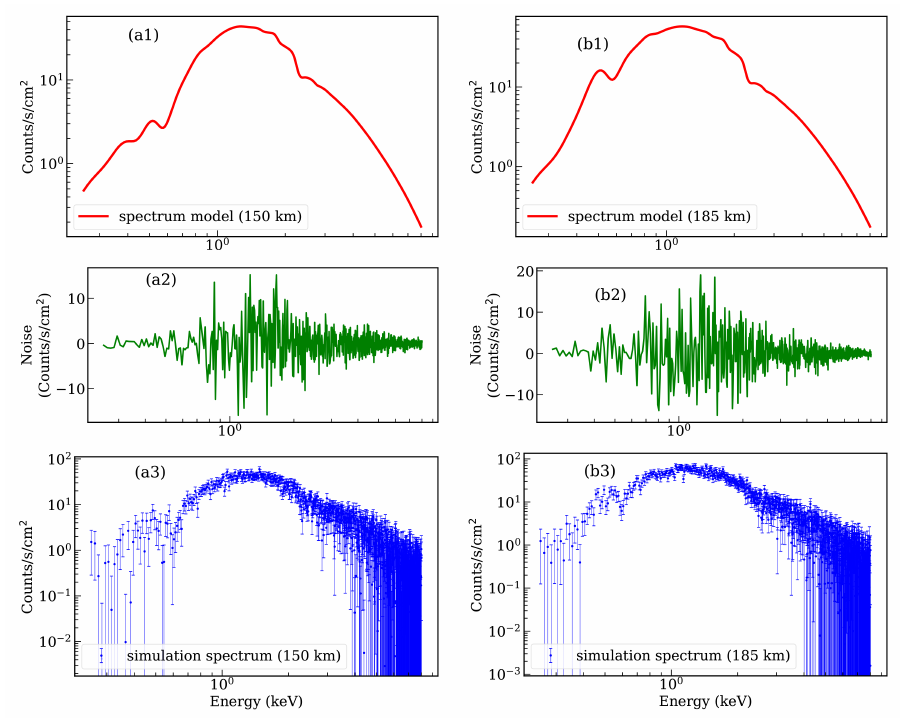
Figure 2. Panels ( a1 , b1 ) are energy spectrum models at 150 km and 185 km, respectively, panels ( a2 , b2 ) are noise, panels ( a3 , b3 ) represent energy spectrum simulation data at 150 km and 185 km,